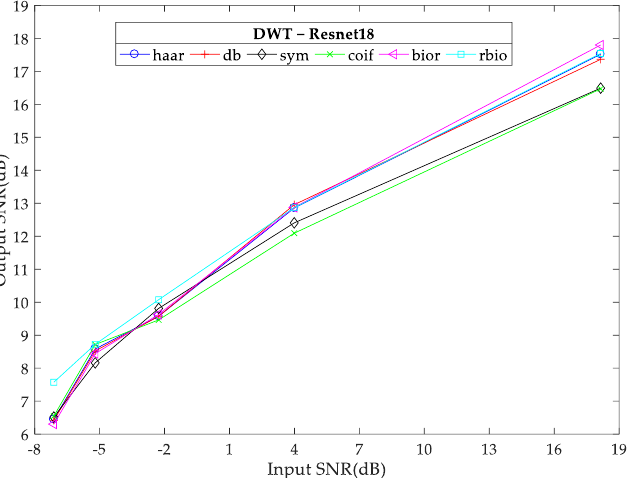
Figure 7. Trend of the best denoising results of DWT−Resnet18 with varying SNRs of real noisy seismic data under different wavelet basis.